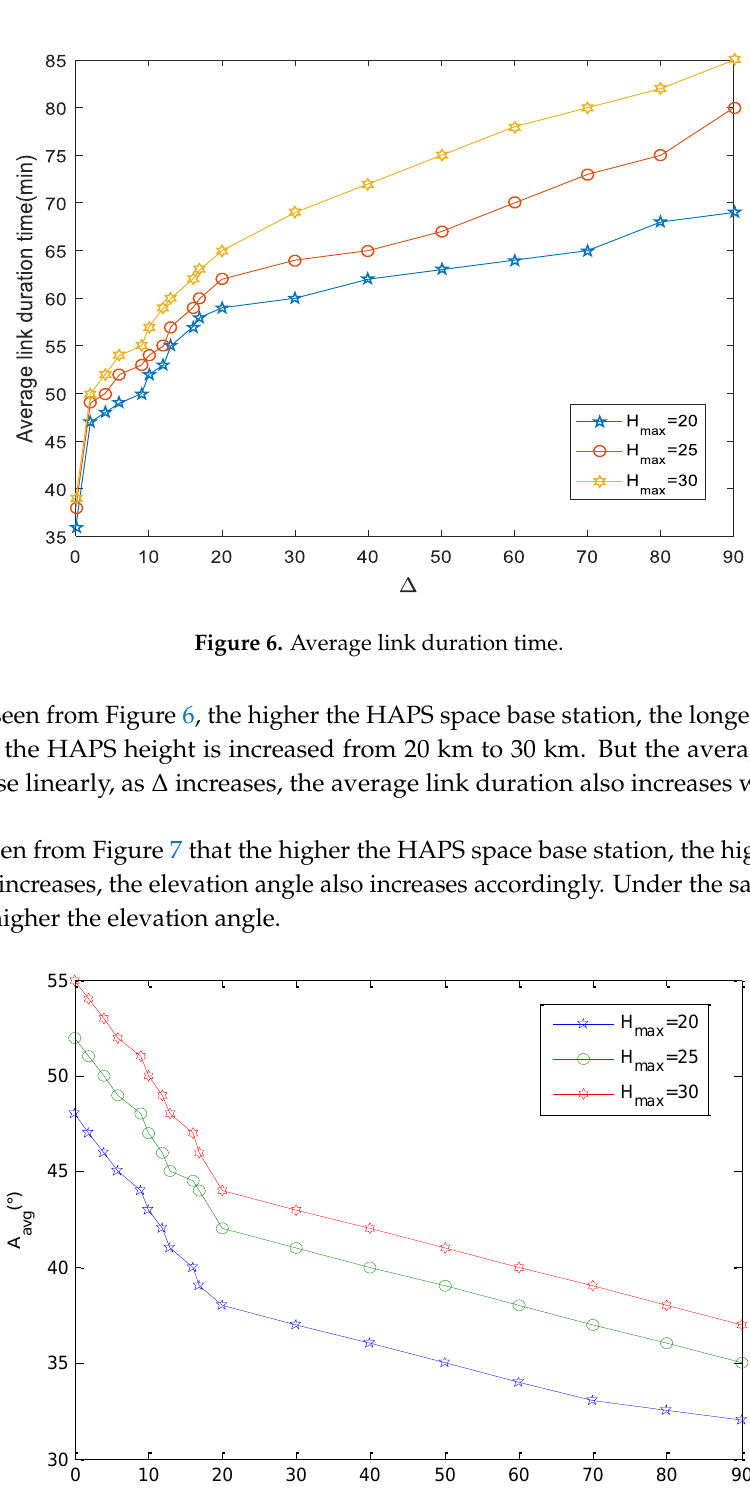
Figure 7. Relationship between elevation angles at different HAPS altitudes.